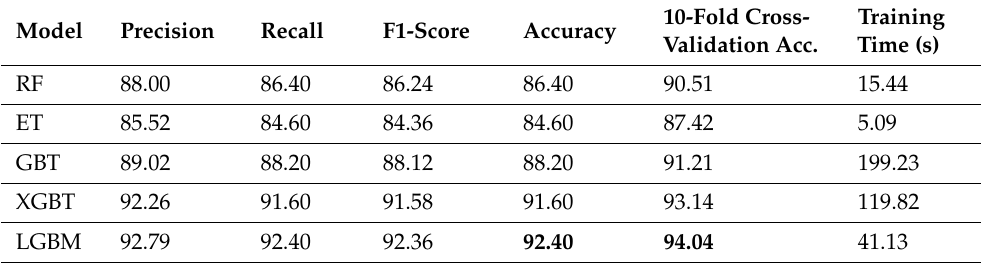
Table 6. Results on the test set with 50 packets as input.